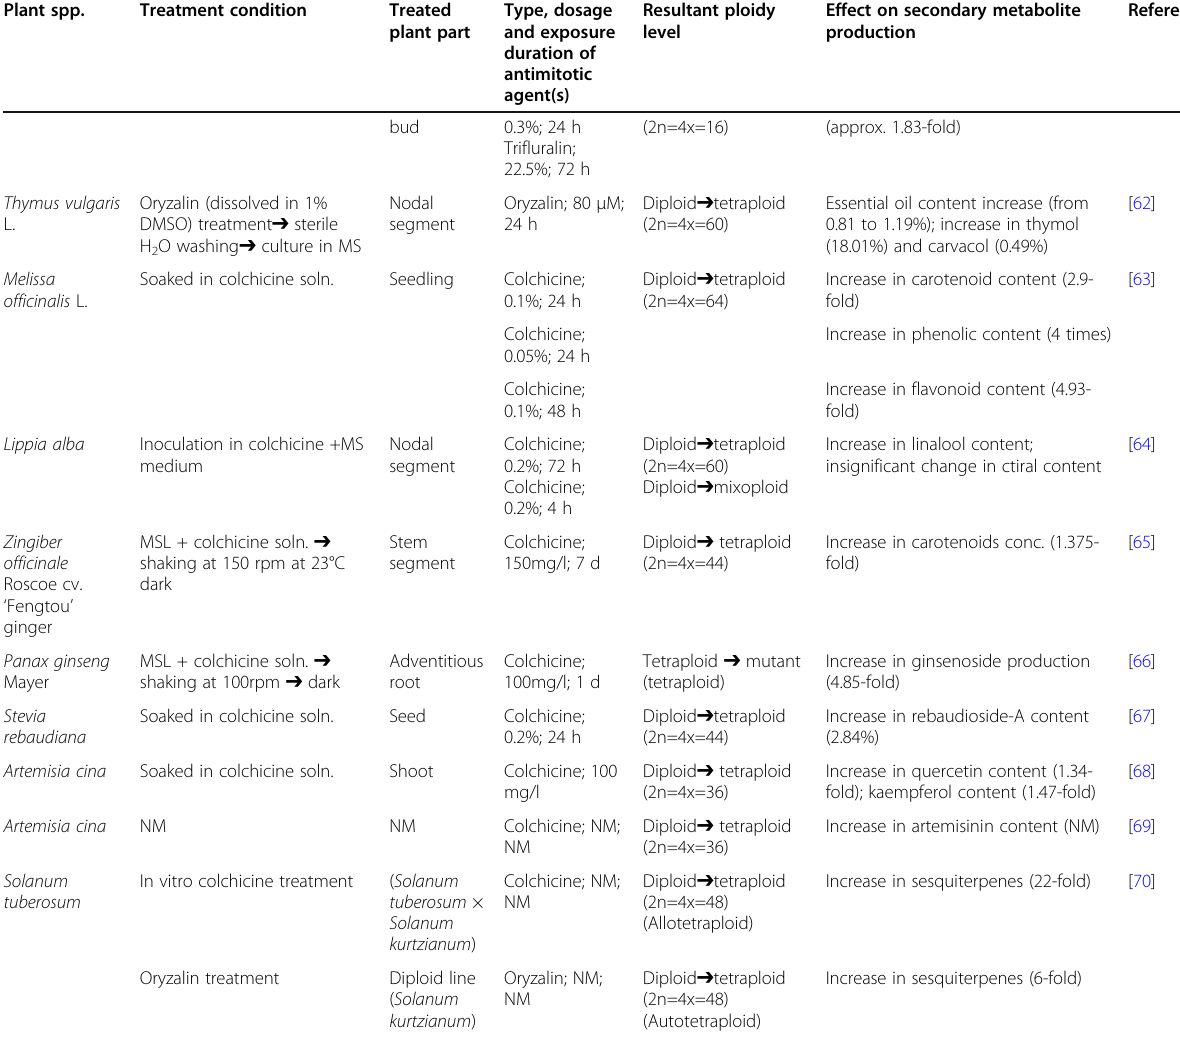
Table 1 Antimitotic agent(s) and their influence on autopolyploidization and subsequent secondary metabolites production (arranged in chronological order) (Continued) Plant spp.